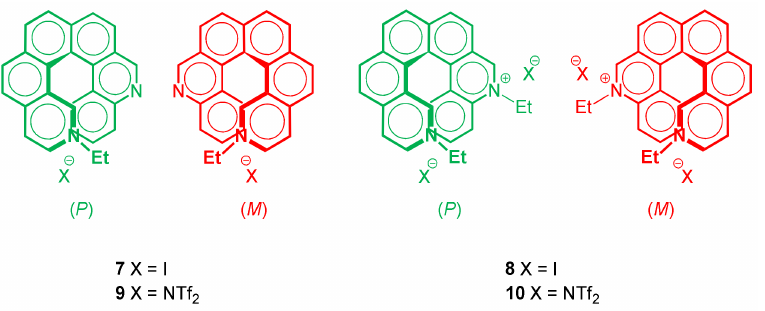
Figure 5. N -ethyl-2,12-diaza[6]helicene-2-ium ( 7 , 9 ) and N,N (cid:48) -diethyl-2,12-diaza[6]helicene-2,12- diium ( 8 , 10 ) salts.